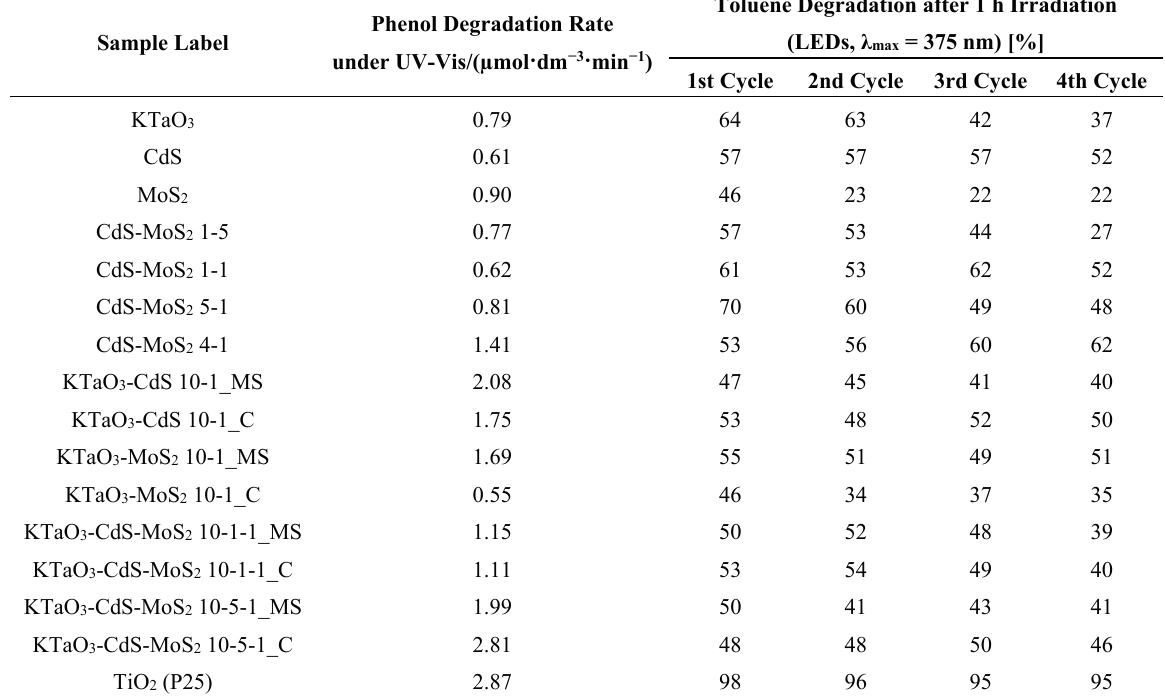
Table 2. Photocatalytic activities of obtained samples for toluene photodegradation in four subsequent measurement cycles and for phenol degradation presented as phenol degradation